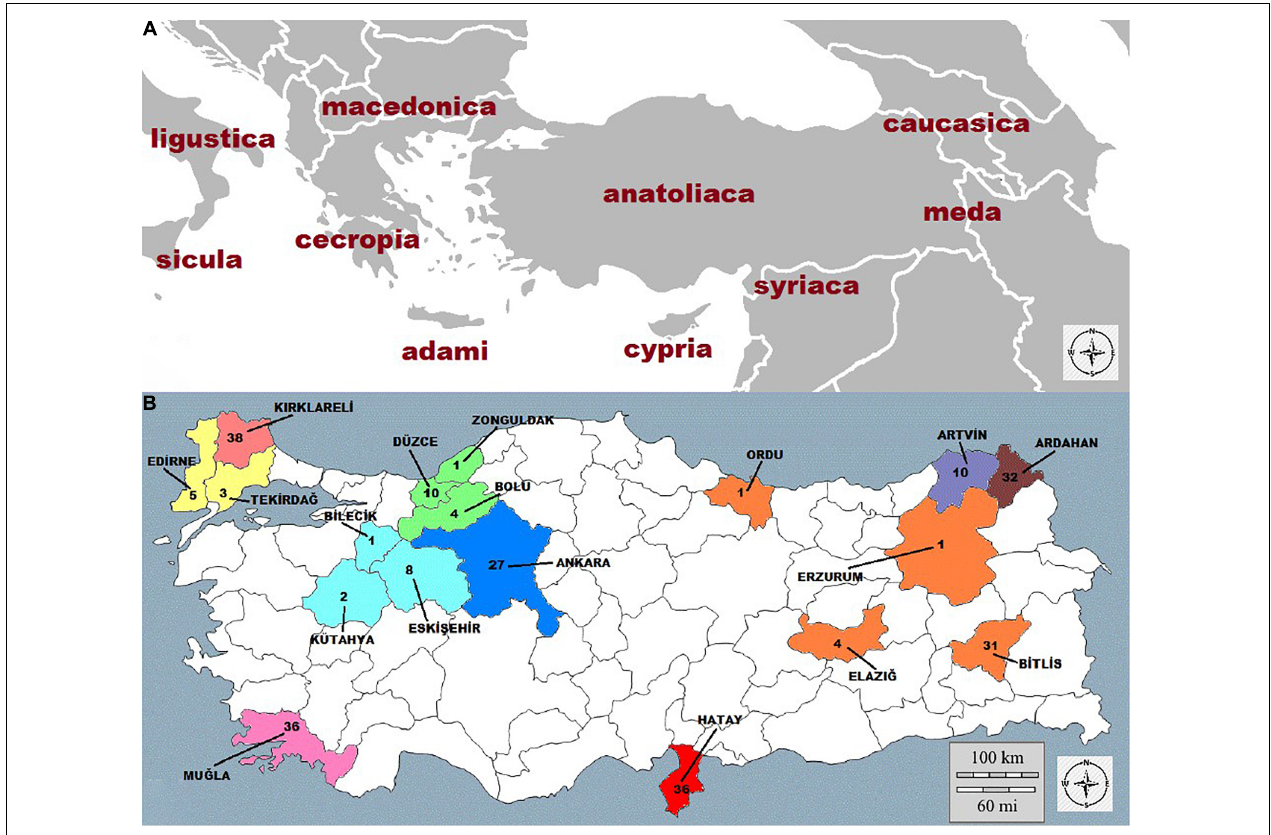
FIGURE 1 | Geographic distribution of (A) major honey bee ( A. mellifera ) subspecies in and around Anatolia (B) sampling sites and sample